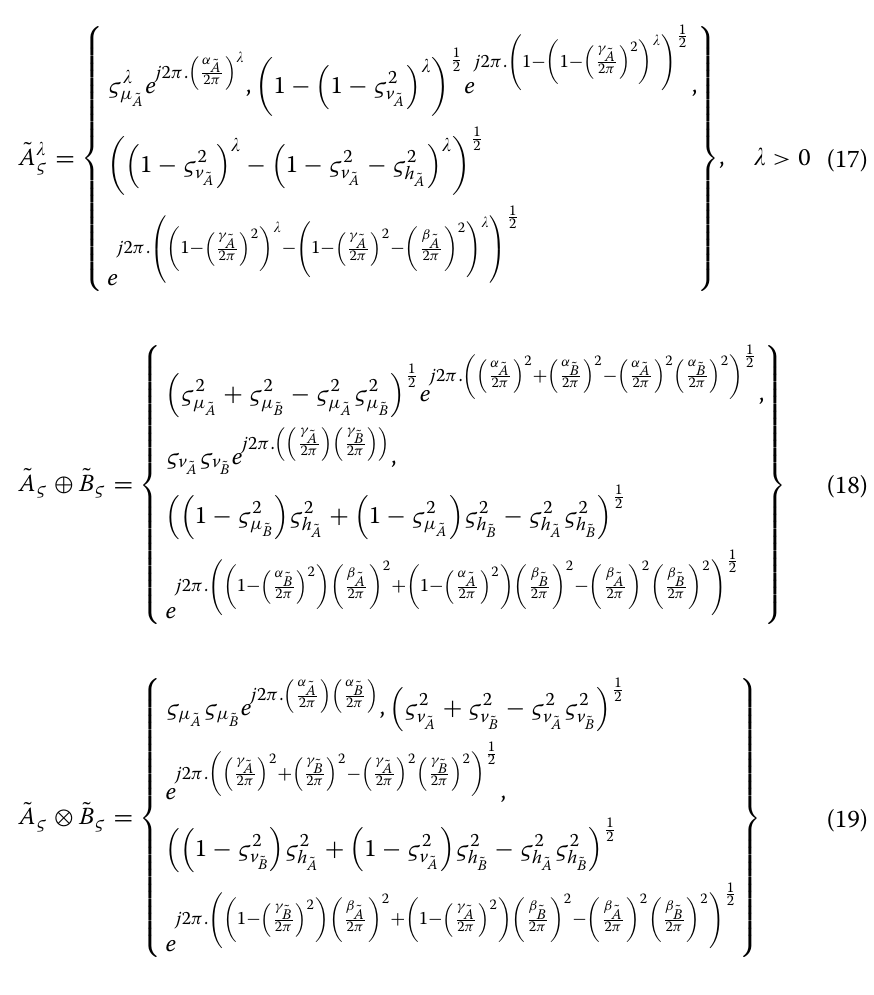
M‑SWARA method with quantum spherical fuzzy sets Kersuliene et al. (2010) introduced the SWARA method with the aim of weighting the various criteria. The hierarchical priorities of experts were considered in this process. The main criticism of the SWARA method is that the causal relationships between items can- not be analyzed. Accordingly, in this study, some improvements are made to this classical SWARA, so that a new technique has been created by the name M-SWARA. The details of the steps in this new technique are provided below. Step 1: The dependency degrees among the criteria are determined by decision-makers. Linguistic evaluations were collected to construct the relation matrix using Table two. Lin- guistic evaluations were performed by an expert team. Step 2: A quantum spherical fuzzy relation matrix is created using these evaluations, as represents the degree of shown in Eq. (20). In this equation, ς µ ˜ A